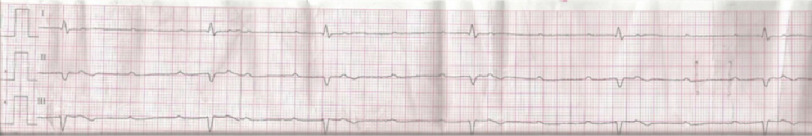
A rhythm strip ECG showing Mobitz type II heart block with 3:1 conduction.